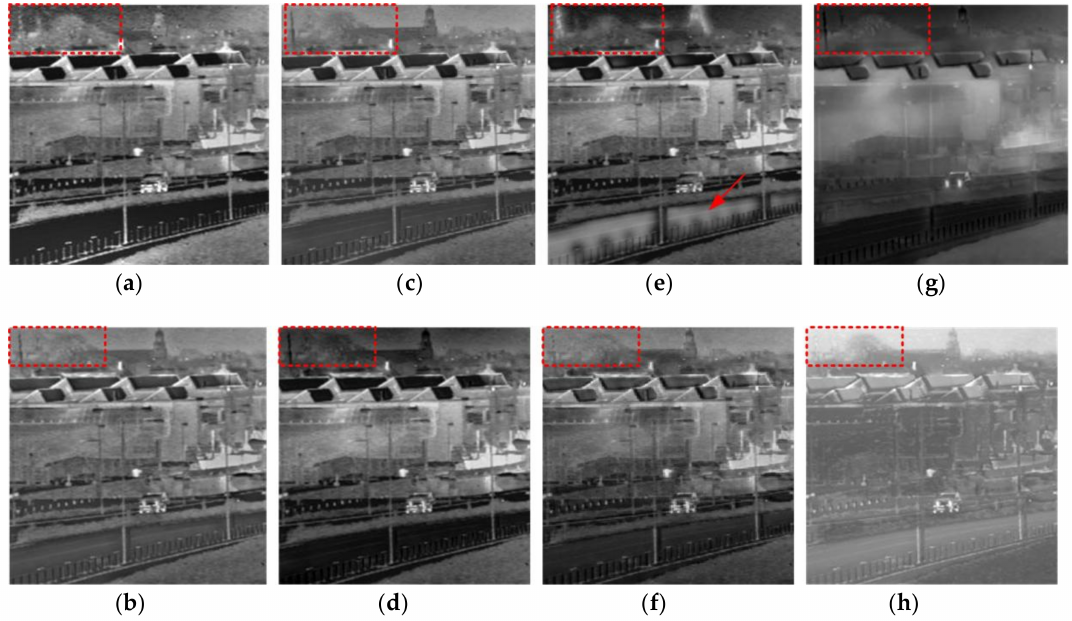
Figure 8. The results for fourth set of images. ( a ) CP; ( b ) PCA; ( c ) GFF; ( d ) SAL; ( e ) GTF; ( f ) NSCT; ( g ) NSST; and ( h )